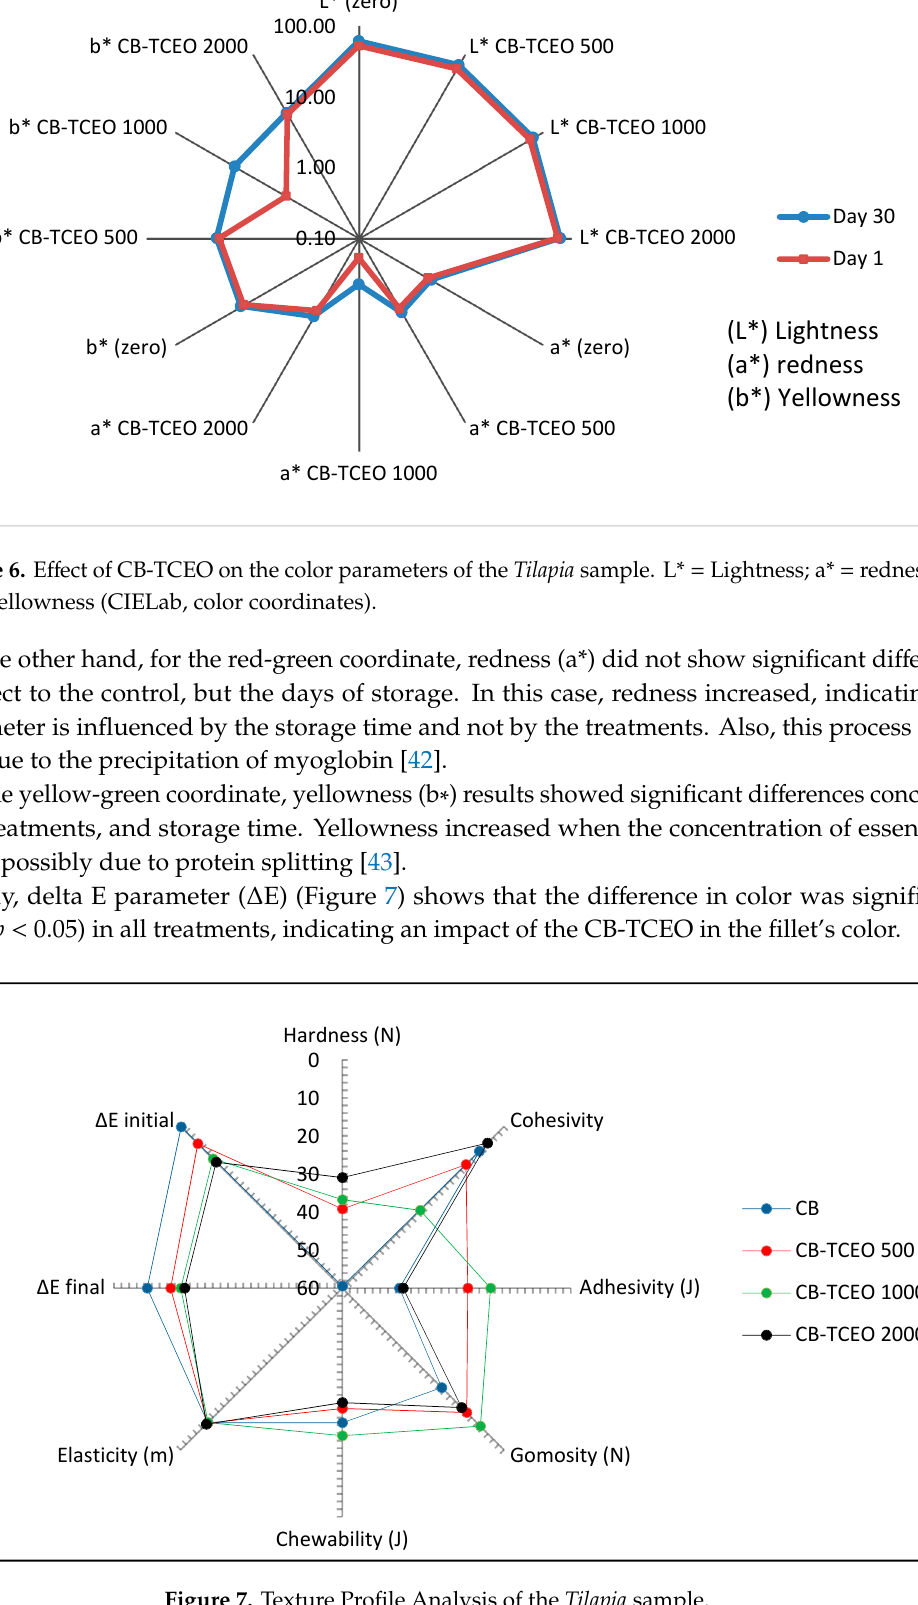
Figure 7. Texture Profile Analysis of the Tilapia sample.